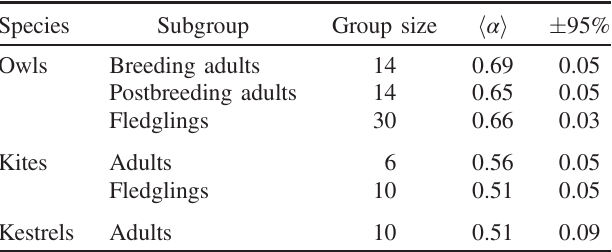
TABLE I. Mean α values for species subgroups, including the individual ’ s number in each subgroup and a 95% confidence interval around the mean. Subgroups are mutually exclusive, except adult owls, with tracks of the same 14 birds divided into breeding and postbreeding periods.